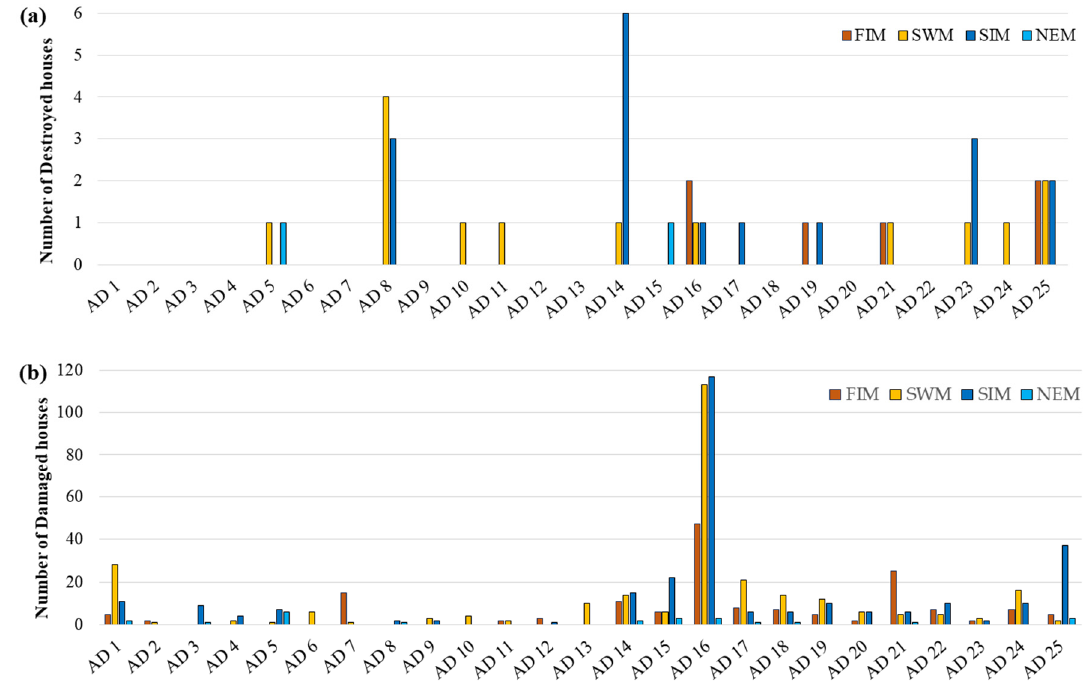
Figure 3. Lightning accidents in Sri Lanka during all four climate seasons, from 1974 to 2019: ( a ) number of damaged houses; ( b ) number of destroyed houses.